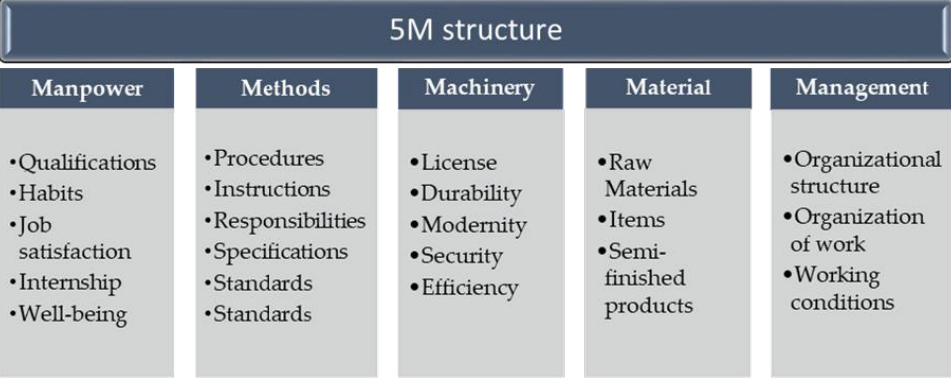
Figure 4. Sample 5M structure layout [59].